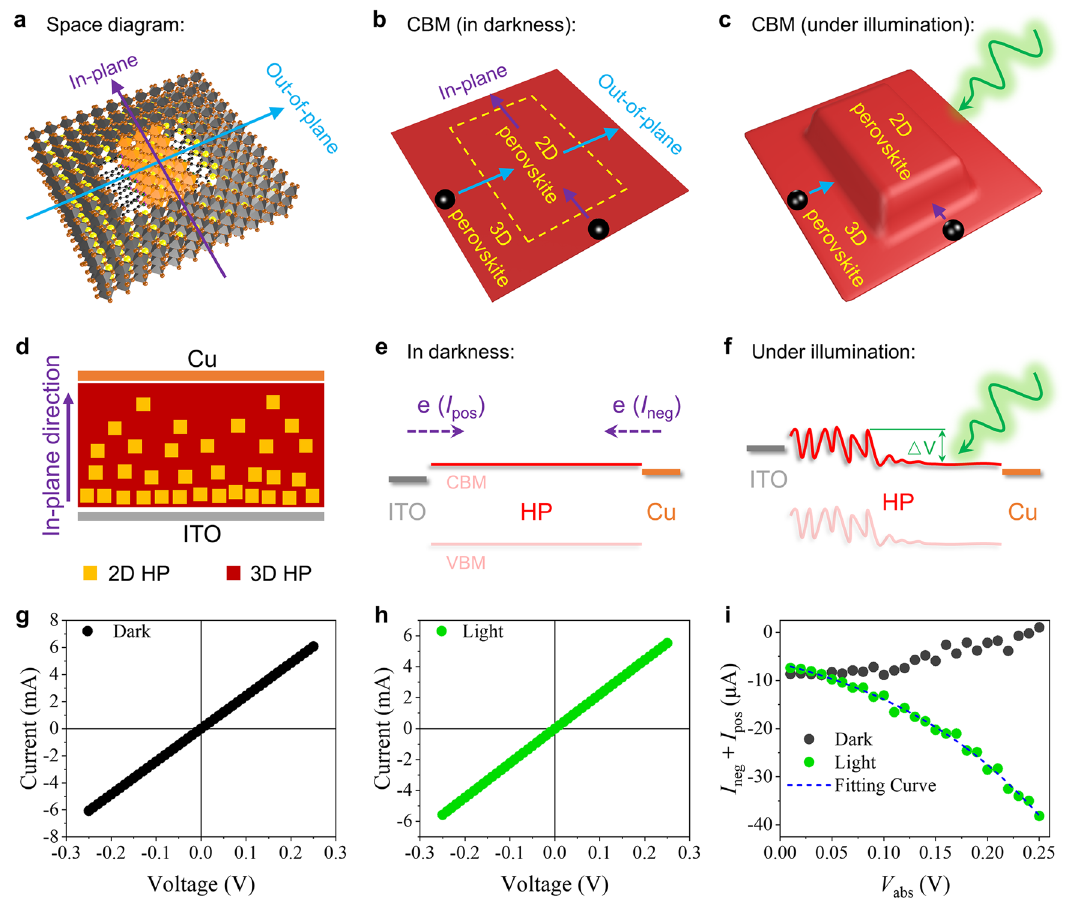
Fig. 6 | Theoretical analysis and experimental veri fi cation of the PCB effect along the in-plane direction of 2D HPs. a Space diagram of the 3D/2D/3D HP con fi guration in typical mixed-dimensional 2D/3D HP fi lms for solar cells. Sche- matic illustration of the corresponding CBM b in darkness and c under illumina- tion. d Schematic diagram of the ITO/HP/Cu con fi guration for the in-plane direction measurement; Schematic diagram of the corresponding energy